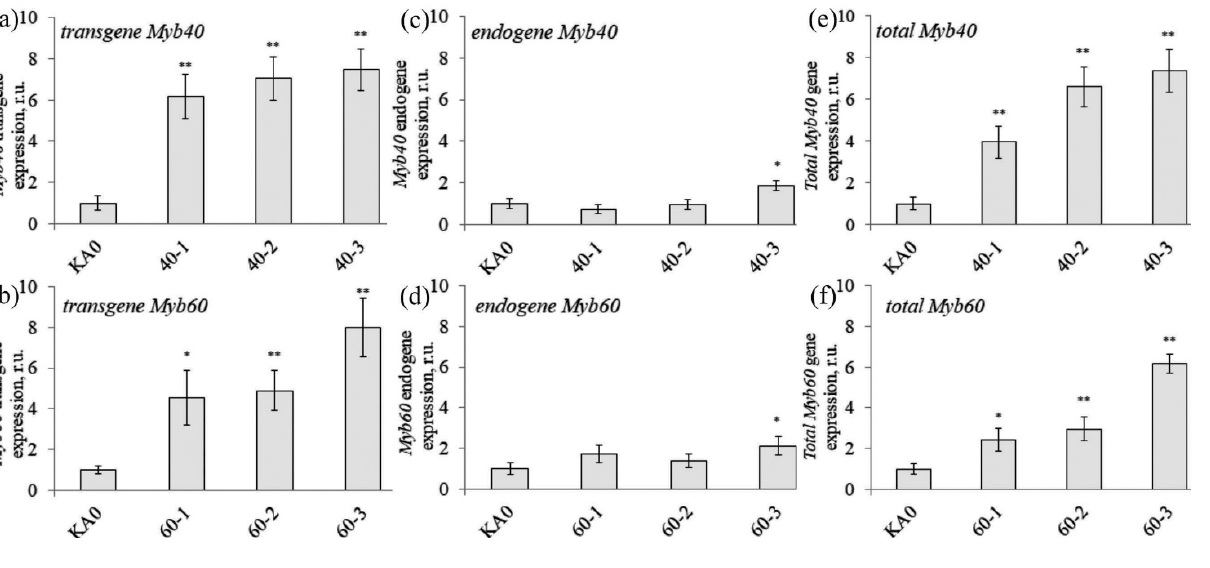
Figure 1. Quantification the transgene ( a , b ), endogenous ( c , d ), and total ( e , f ) mRNAs of the VaMyb40 and VaMyb60 genes in the transgenic callus cell lines of Vitis amurensis performed by quantitative RT-PCR. KA0—the control KA0 cell line of V. amurensis transformed with the vector harboring only the npt II selective marker; 40-1, 40-2, and 40-3—cell lines of V. amurensis transformed with the VaMyb40 gene; 60-1, 60-2, and 60-3—cell lines of V. amurensis transformed with the VaMyb60 gene. The data are presented as mean ± SE (two independent experiments with eight technical replicates). *, **—significantly different from the values of Myb expression in the control KA0 cell line at p ≤ 0.05 and 0.01 according to the Student’s t-test.